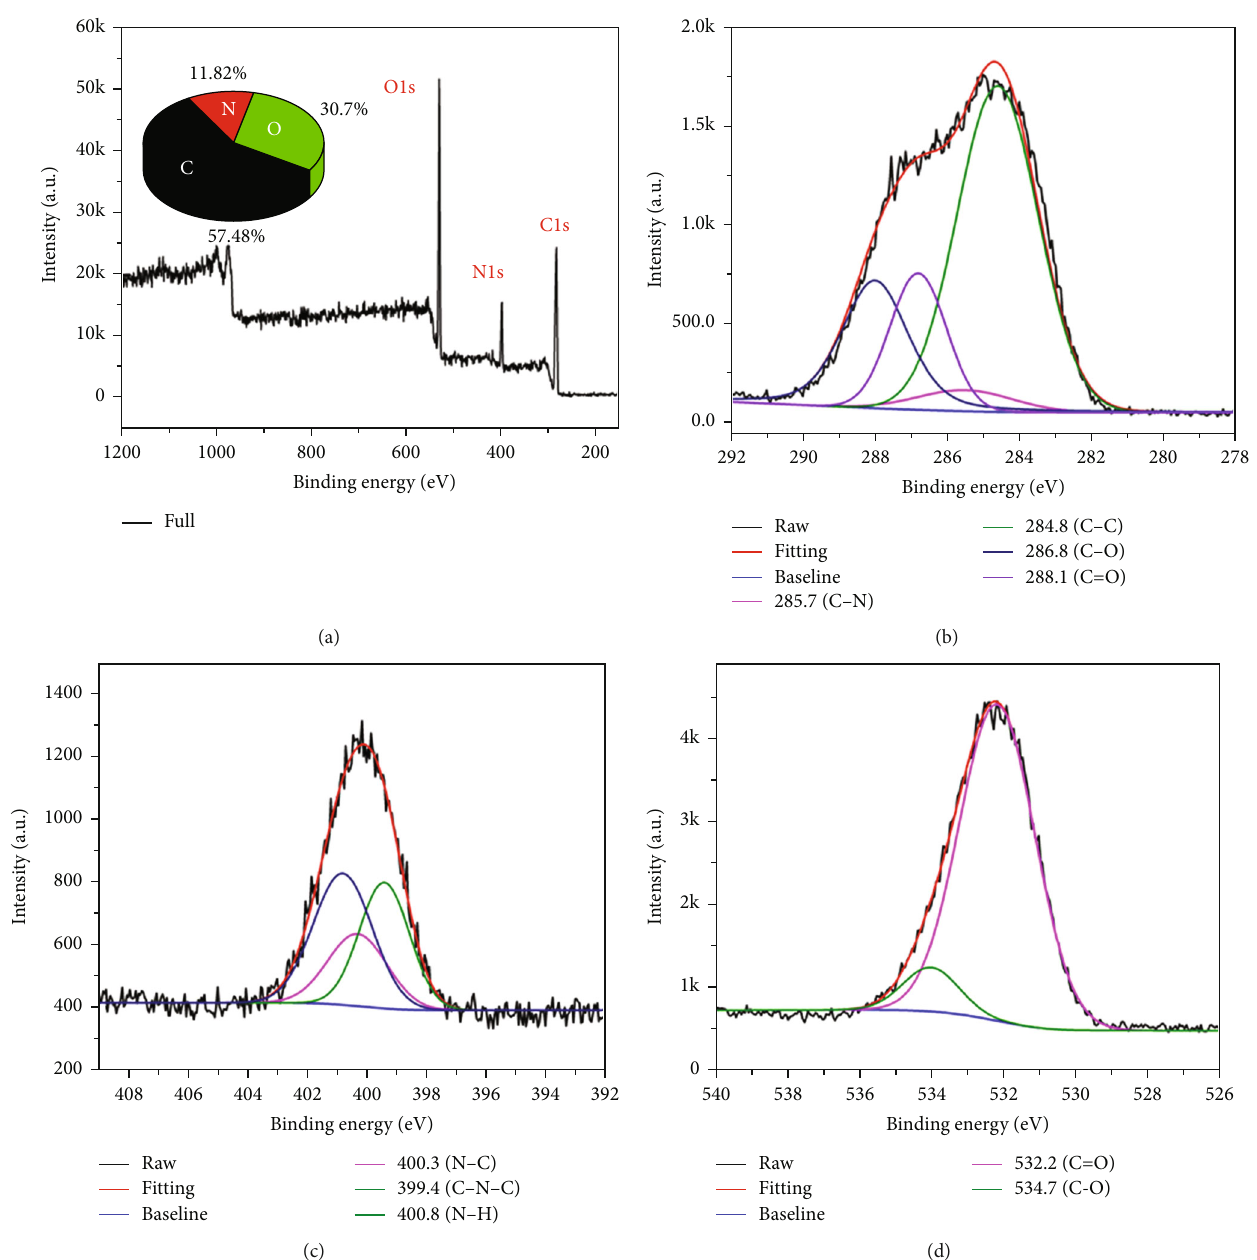
Figure 3: (a) XPS full spectrum of the CQDs, and (b – d) high resolution C1s, N1s, and O1 spectra of the